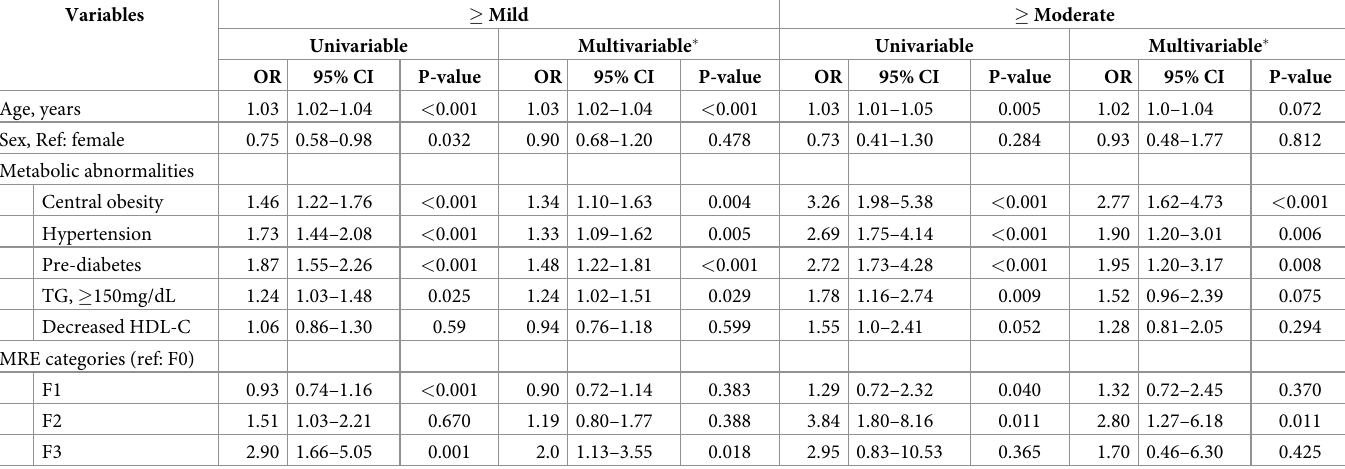
Table 4. Association of CKD with liver fibrosis in